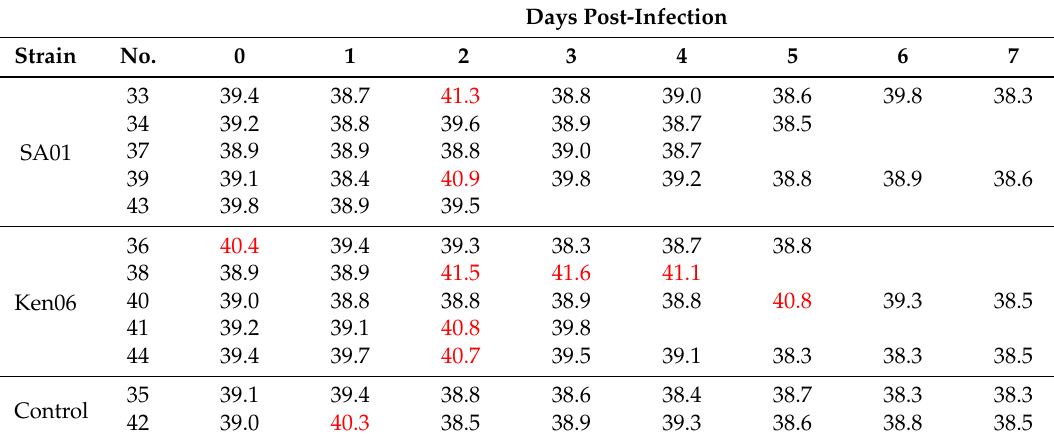
Table 2. Kinetics of the rectal temperature ( ˝ C) of calves infected with Rift Valley fever virus (RVFV) strains, Saudi Arabia 2001 (SA01) and Kenya 2006 (Ken06) (red indicates above normal for cattle, >40 ˝